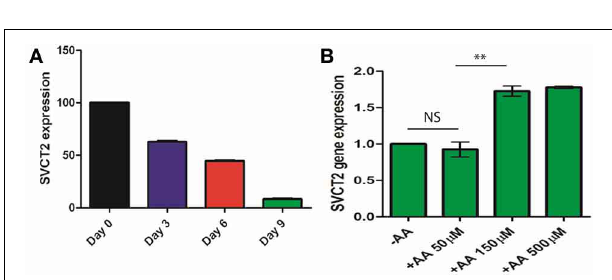
dibutyrylcAMP (dBcAMP), dBcAMP+IBMX, or dBcAMP plus AA at two doses. Lipids accumulation has been evaluated using adipored technique (see Materials and Methods). Fluorescence has been recorded. ∗∗ p < 0 . 01.